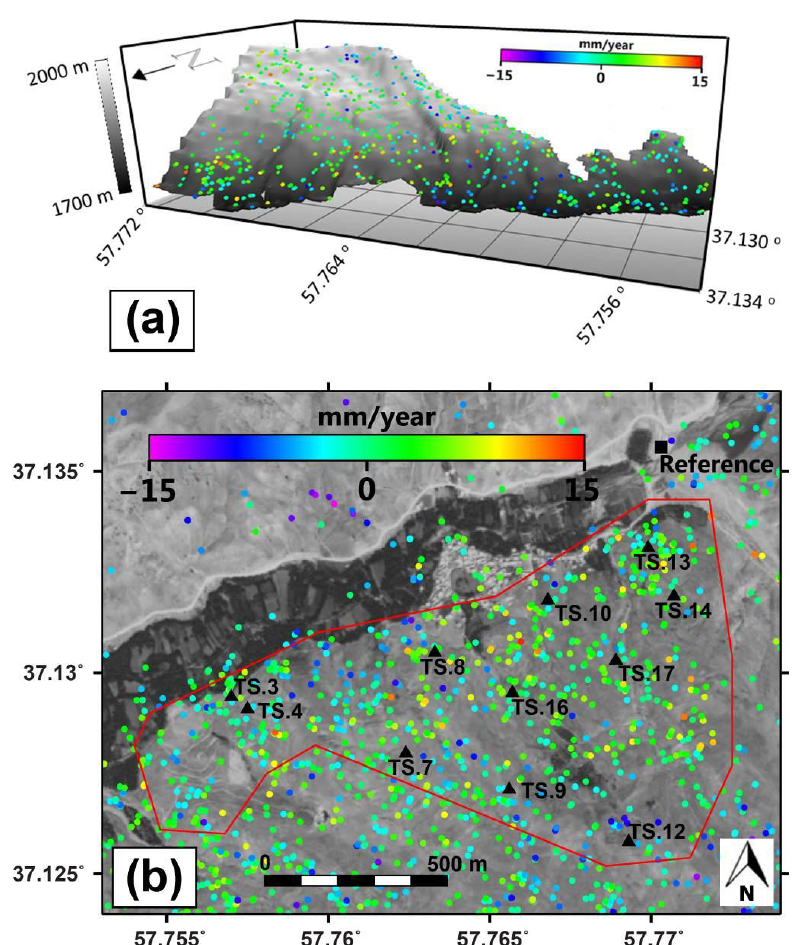
Figure 9. ( a ) Mean velocity map of the Sarcheshmeh slope in oblique geometry derived from InSAR time-series analysis; ( b ) a close up view of the mean velocity map in geographical coordinates; selected points for the time-series analysis are indicated by bold triangular points and a reference point is indicated by a bold rectangular